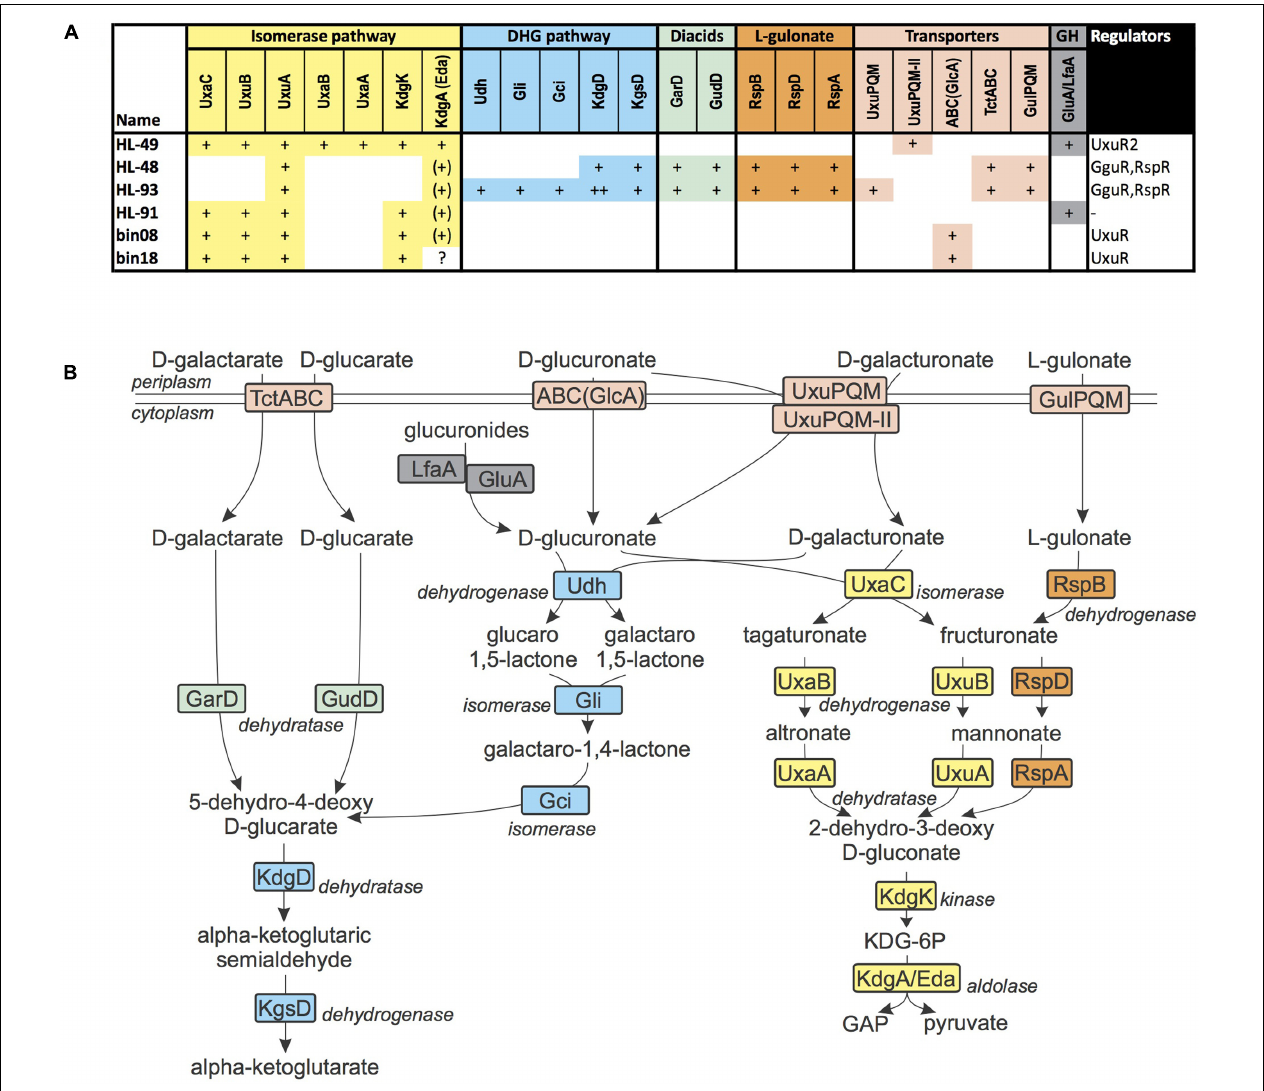
FIGURE 4 | D -Glucuronate, D -galacturonate, D -glucarate, D -galactarate, and L -gulonate utilization in UCC bacteria. (A) Distribution of enzymes from the sugar acid utilization pathways in UCC genomes. Presence of enzymes is marked by “+” for each gene with a given function. Each pathway colored by distinct color. Enzymes from central carbohydrate metabolism (CCM) are marked by “(+).” Missing enzymes are marked by “?” (B) Scheme of sugar acid utilization pathways in UCC genomes. Enzymes are colored by matching colors as in (A)